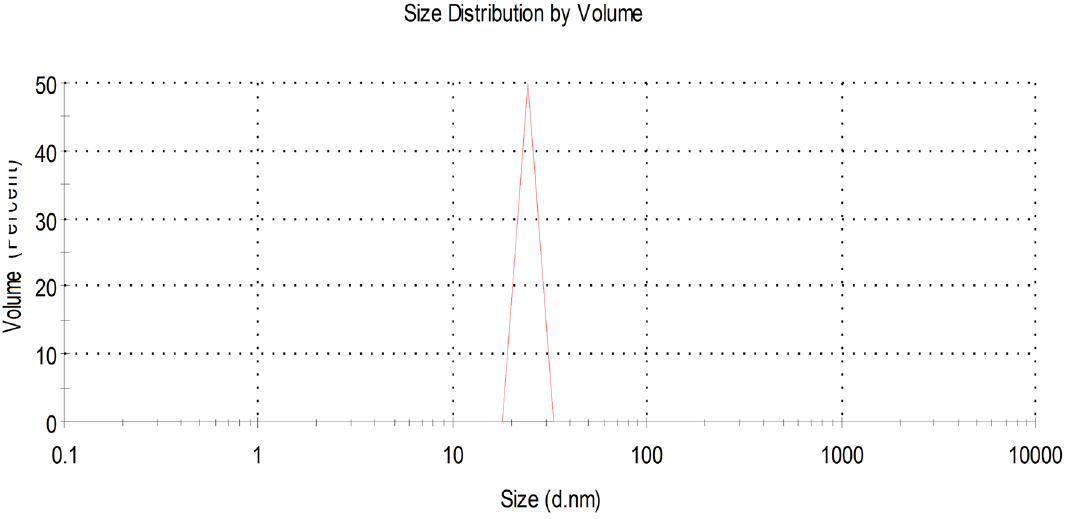
Fig. 3 Particle size distribution of AgNPs by